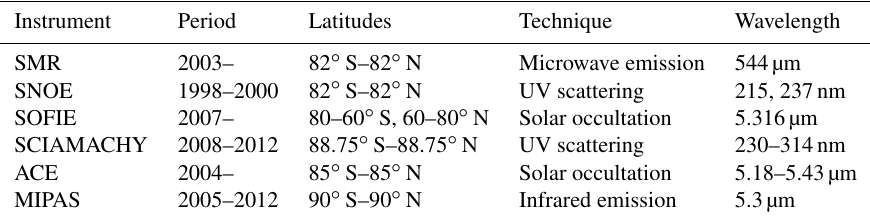
Table 2. Overview of all the compared NO datasets.